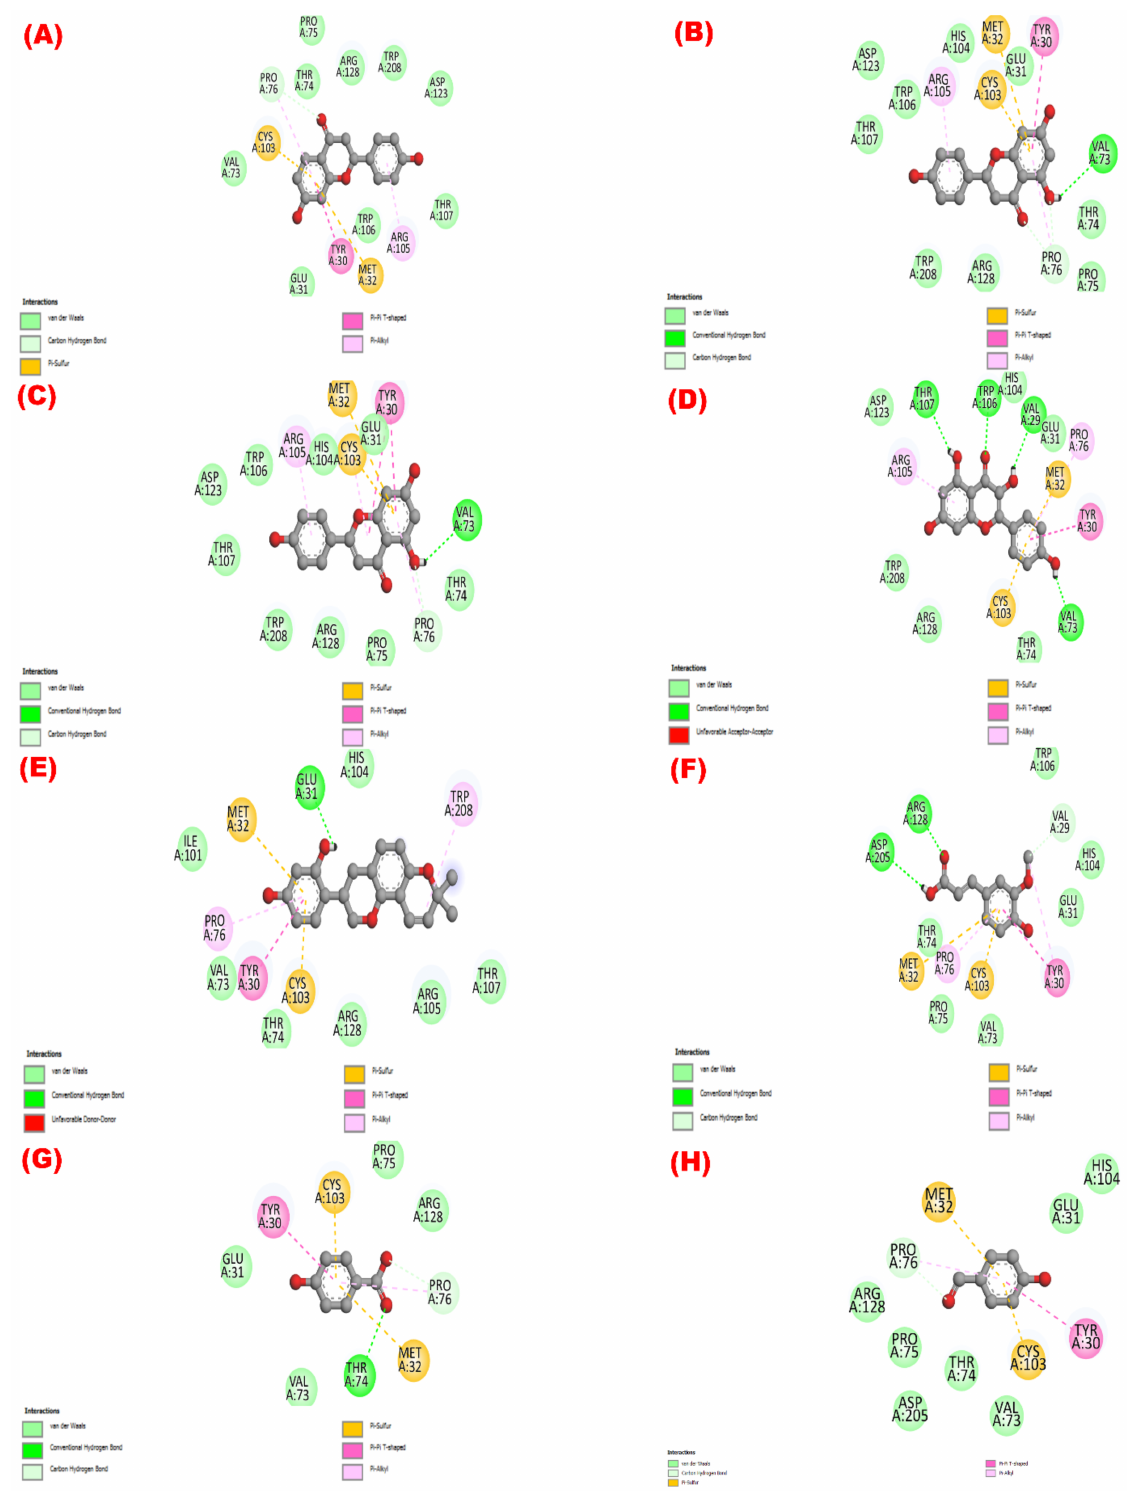
Figure 3. The isolated phytochemicals’ potential as antioxidants showing their 2D molecular in- teractions with the urase oxidase enzyme (PDB ID: 1R4U). The 2D visual images of the molecular docking of the molecules ( 1 to 8 ) liquiritigenin, naringenin, apigenin, kaempferol, glabridin, ferulic acid, 4-hydroxybenzoic acid, and 4-hydroxybenzaldehyde are shown in ( A – H ),